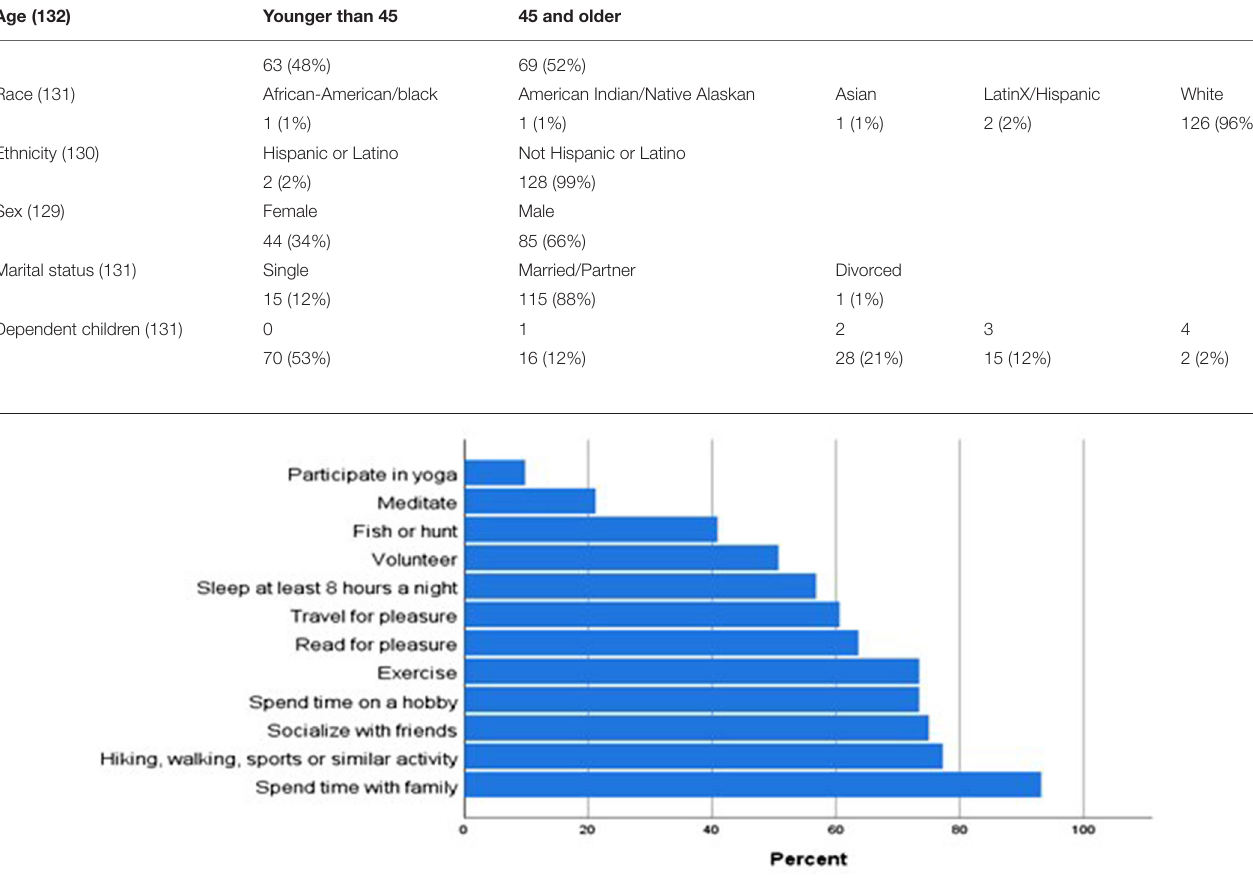
FIGURE 1 | Engagement in healthy behaviors at least sometimes ( n